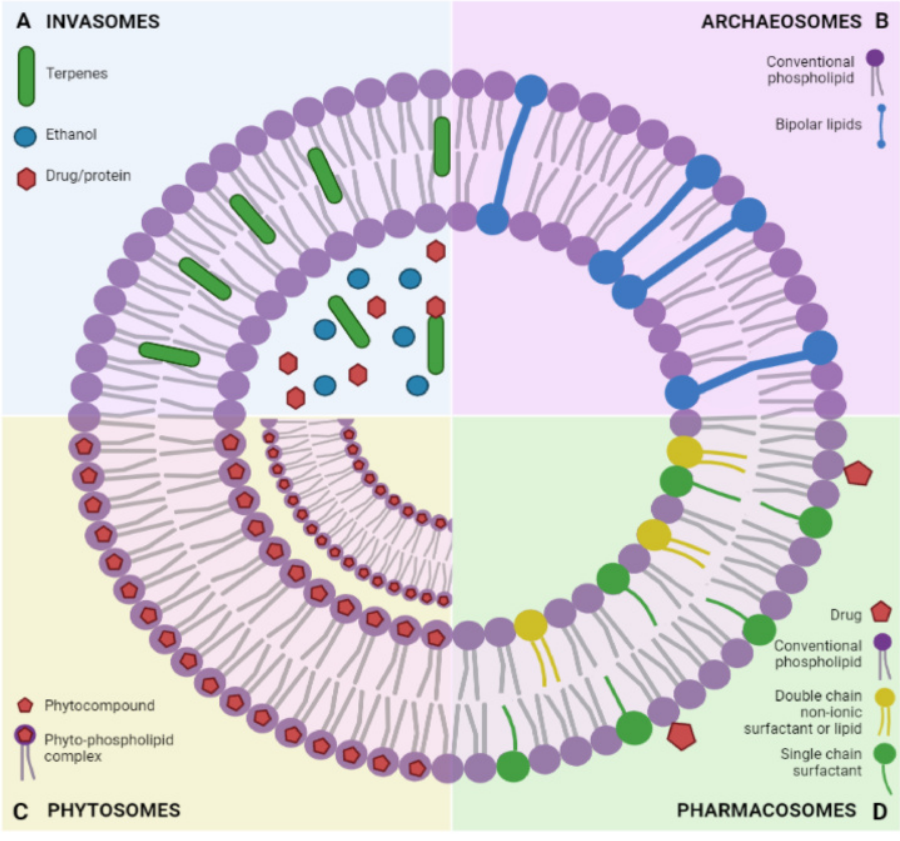
Figure 8. The structure and content of some types of lipidic vesicular systems: invasomes ( A ), archaeosomes ( B ), phytosomes ( C ), and pharmacosomes ( D ). Created with BioRender.com (accessed on 10 January